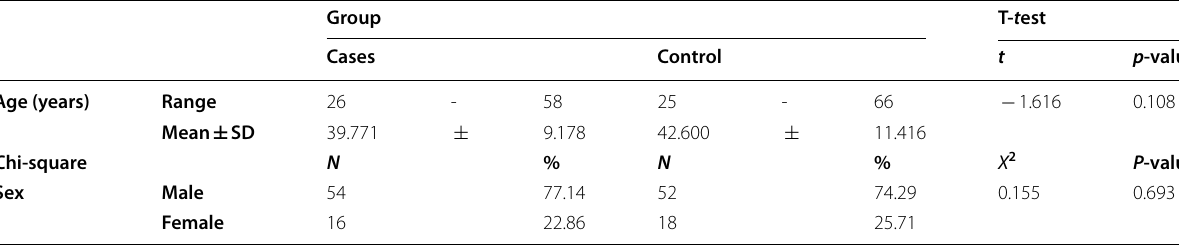
Table 1 Age and sex comparison of the AS group with the control group Group T- t est Cases Age (years) Range Chi-square N % Sex SD Standard deviation P -values 0.05 are significant, and P -values 0.01 are highly significant ≤ ≤